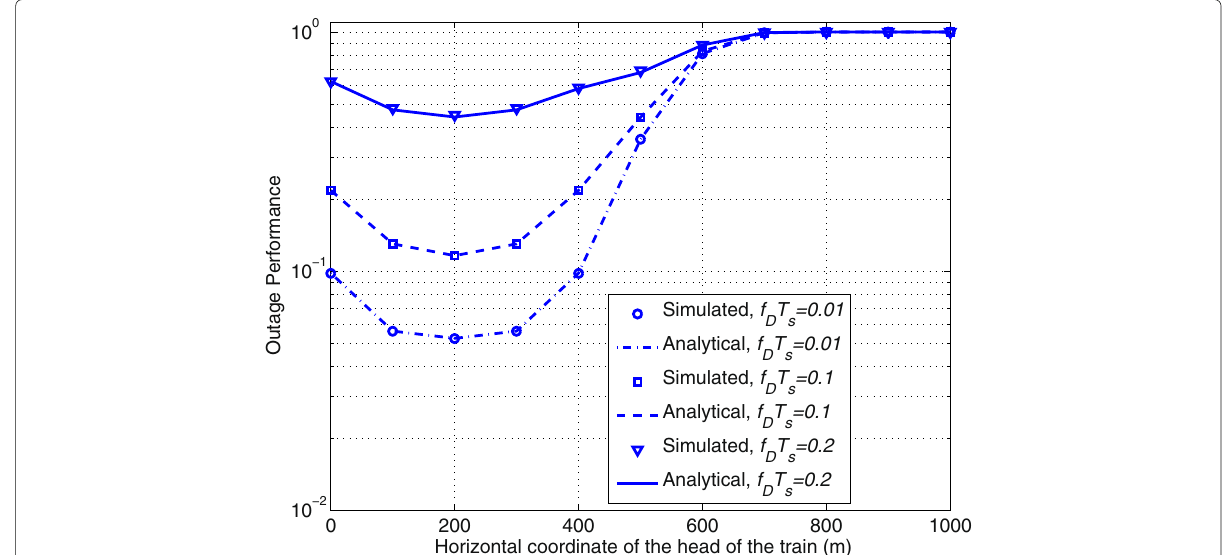
Fig. 8 Outage probability as a function of the horizontal coordinate of the first distributed mobile relay antenna ( N = 4 and γ = 10